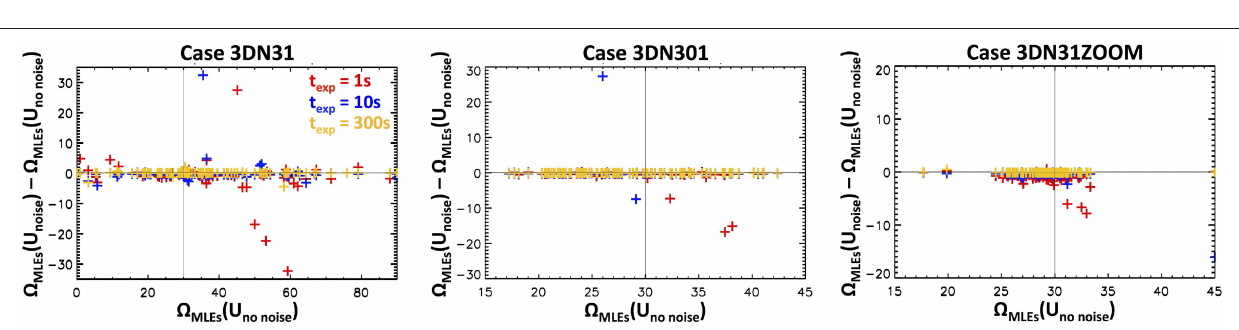
FIGURE 11 | Scatter plots showing the effect of noise on the MLEs obtained with ROAM for all designs of 3DN31, 3DN301, and 3DN31ZOOM. The horizontal, thin black line indicates the zero error level, while the vertical thin black line indicates the ground-truth value.